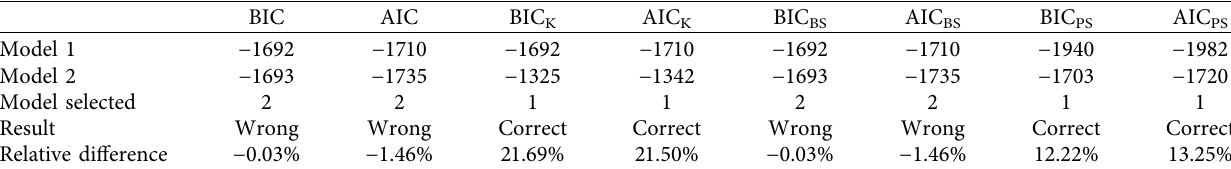
Table 2: Estimates of the various versions of the indicators for the examples of equations (16)–(18).